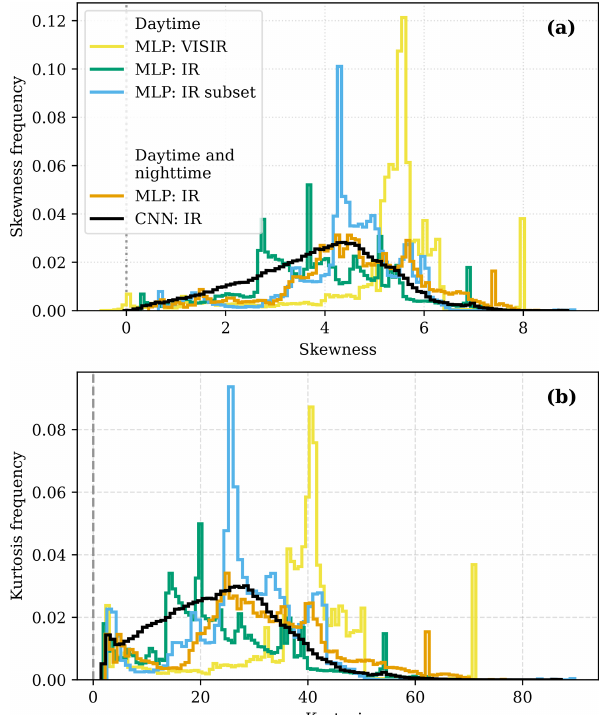
Figure 6. Skewness (a) and kurtosis (b) frequencies for all QRNN predictions with DARDAR IWP between 10 − 3 kgm − 2 and 10 + 1 kgm − 2 , indicating the network architecture, input settings, and training observations used (corresponds to results shown in Figs. 5 and